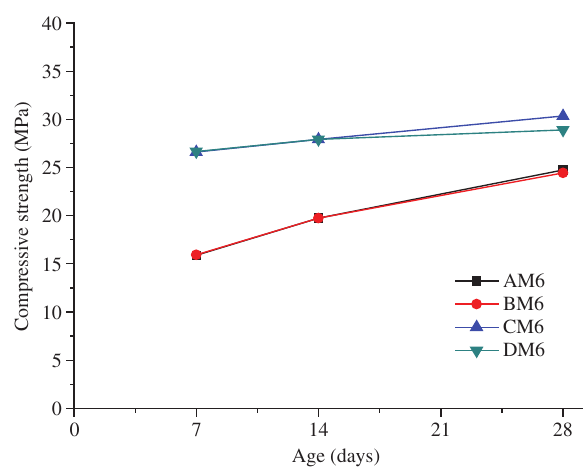
Figure 3: Compressive strength development of AAFA geopolymer with the alkaline solution/binder ratio of 0.65 vs. age.